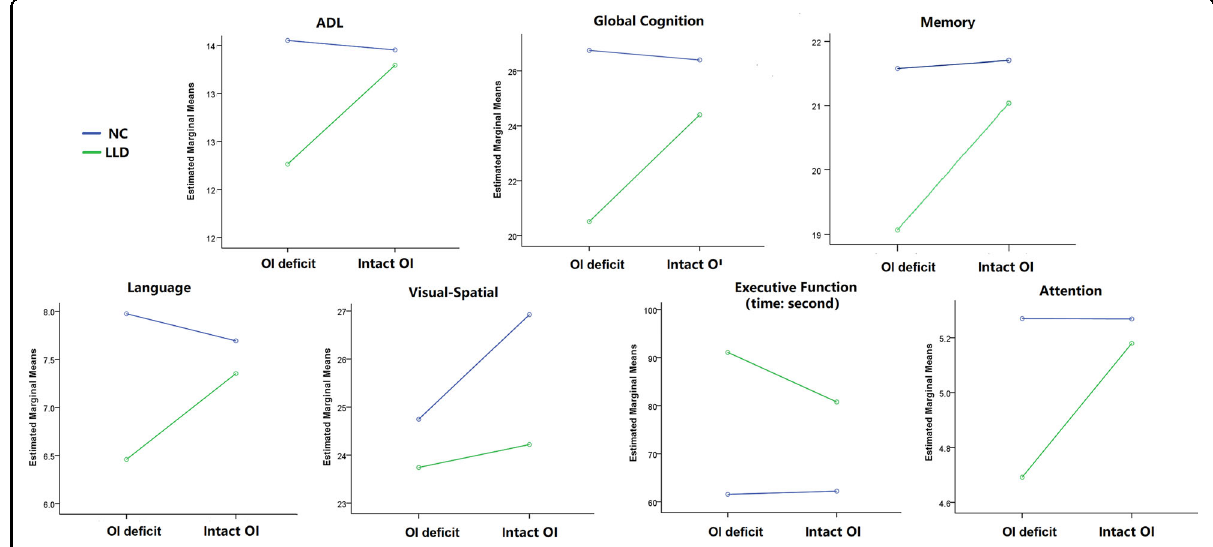
Fig. 1 Additive effects of LLD and OI dysfunction on cognitive impairment and ADL disability. Two × two factorial analyses were used to analyze the in fl uence of the factor “ Depression ” (LLD and NC) and the factor “ Olfaction ” (OI dysfunction and intact OI) on neuropsychological scores; control variables included age, sex, and years of education. LLD, late-life depression; NC, normal controls; OI, odor identi fi cation.